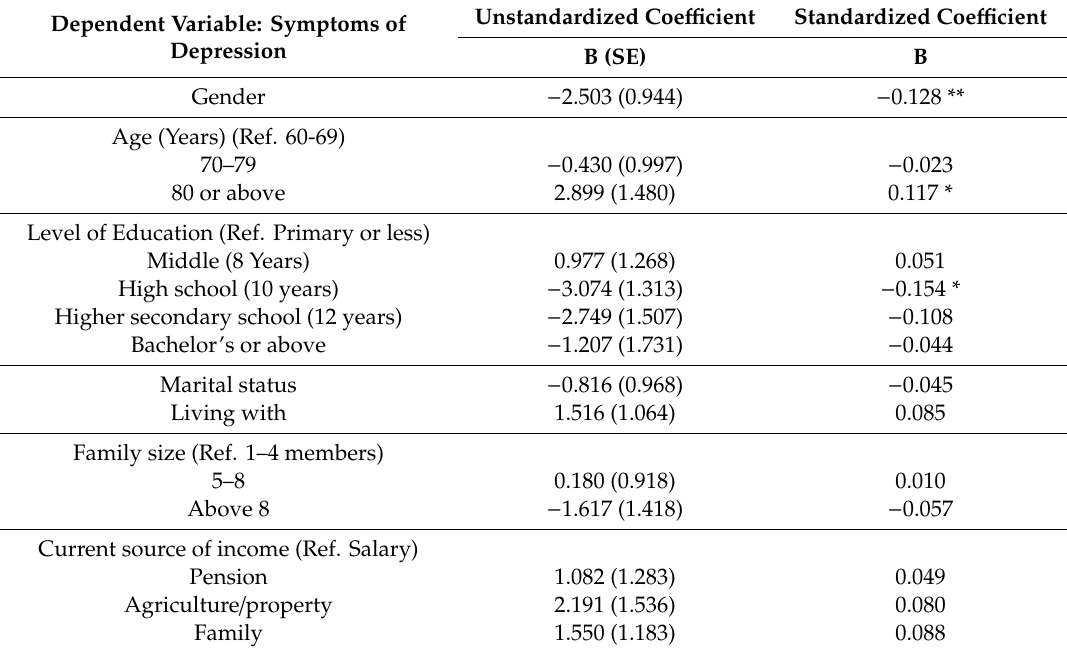
Table 3. Multiple linear regression on symptoms of